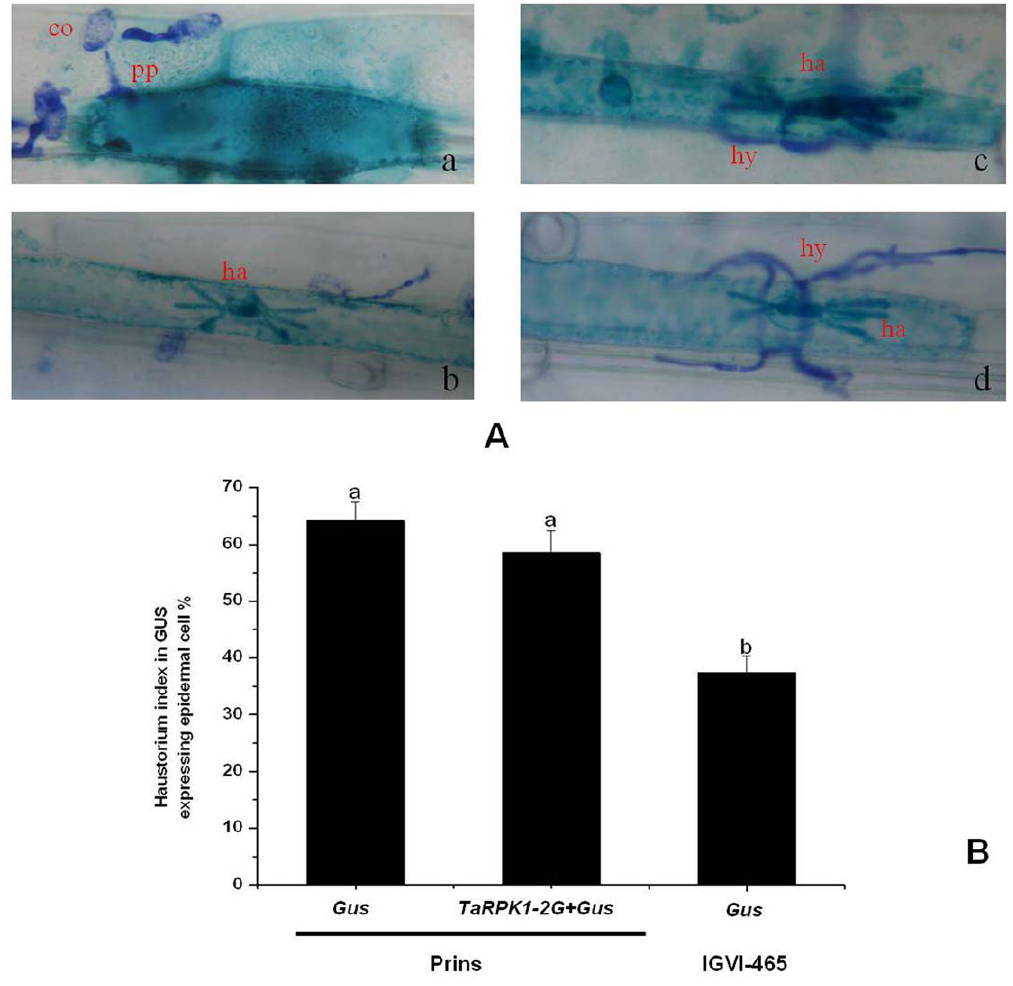
Figure 6. Functional analysis of the TaRPK1-2G by single cell transient expression assay in interaction with Bgt . A. The compatible and incompatible interactions between the positive transformed cells of the target gene with Bgt fungus. a: incompatible interaction in which the formation of haustorium failed. b, c, d: compatible interaction in which the formation of haustorium succeeded. co: conidia; pp: penetration peg; ha: haustorium; hy: hyphae. B. The haustorium index in the GUS transformed cells or in the GUS and TaRPK1-2G co-transformed cells. Bars with different letters show significant differences at the P , 0.05 level; differences of the haustorium index were compared between the GUS transformed cells and the TaRPK1-2G + GUS co-transformed cells using Prins (susceptible) as the receptors, and between the GUS transformed cells using IGVI-465 (resistant) as the receptor.